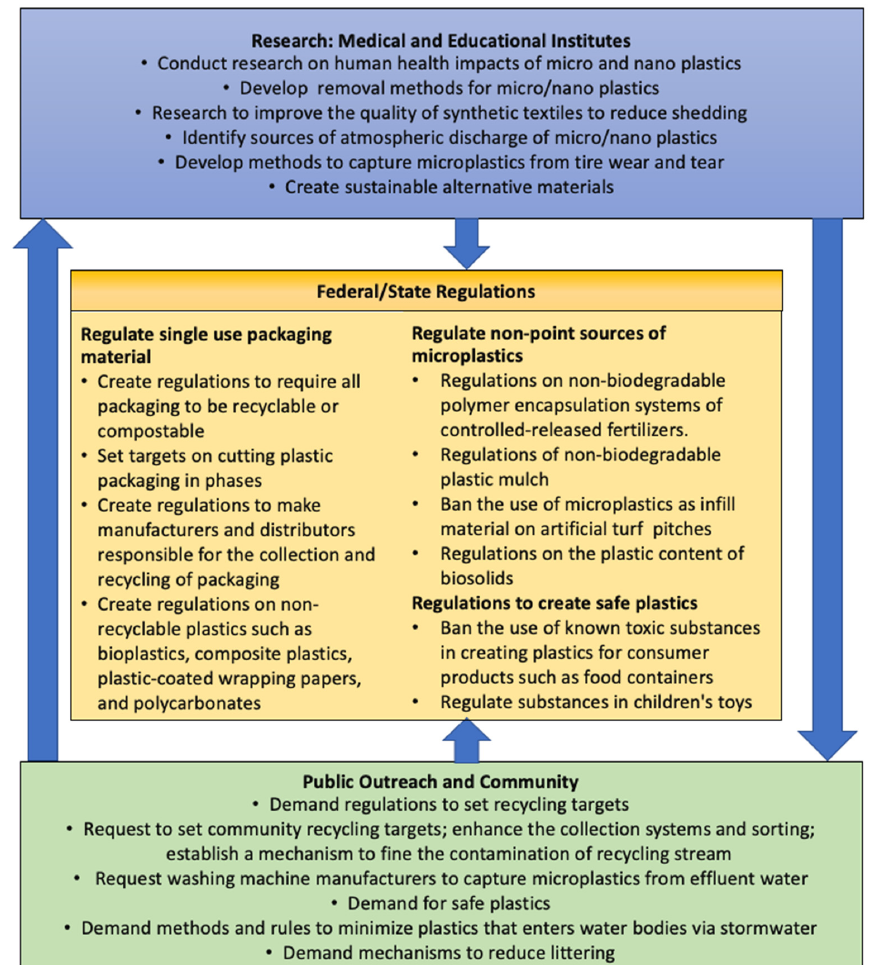
Figure 1. Action plan for reducing the MP and NP pollution.